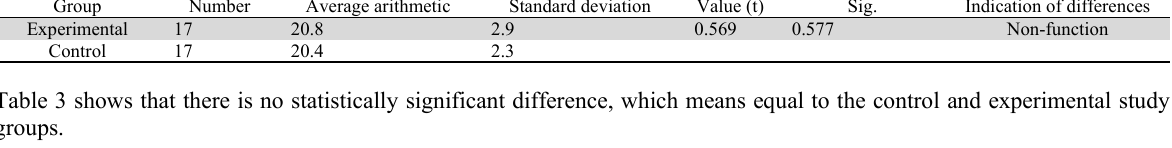
Test (T) for independent samples to compare the arithmetic average and standard deviation Group Number Average arithmetic Standard deviation Value (t)